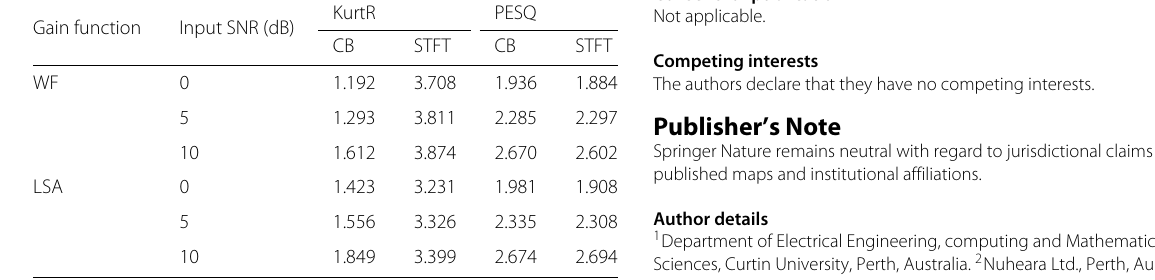
Table 15 Objective results comparison as a function of input SNR for babble noise Gain